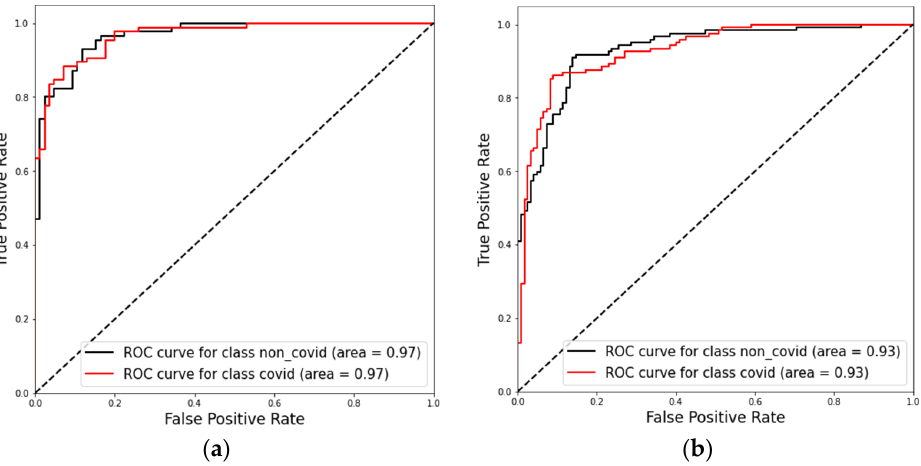
Figure 8. ROC curves obtained for model evaluation on the test dataset 1 ( a ) and on the test dataset 2 ( b ).